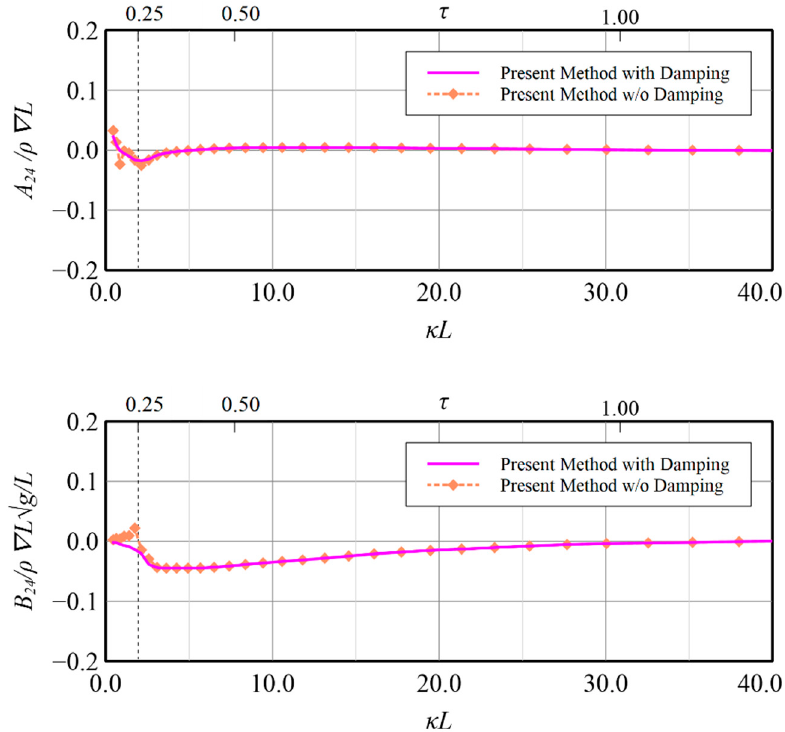
Figure 23. Roll-induced-sway added mass and damping coefficient at F r = 0.18.